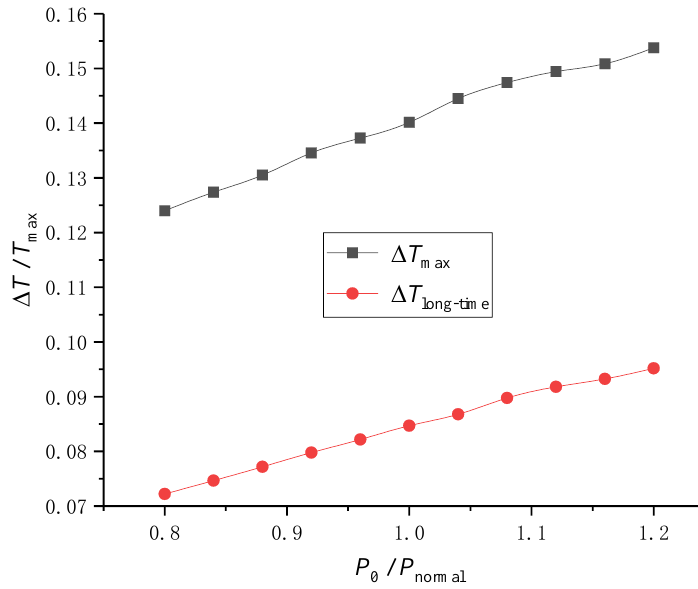
Figure 10. The temperature difference in different initial pressures. The temperature difference ∆ T in different water leakage flows are shown in Figure 11. The water leakage flow had little effect on the temperature difference. This is because the water leakage flow was far less than the feedwater flow in normal operation and there were multiple J-type tubes distributed on the feedwater ring of the steam generator. Under different low water leakage flows, the feedwater entered the descending channel through different numbers of J-type tubes, so their velocities were almost equal, and the values of Ri were almost the same. Therefore, the water leakage flow had little effect on the thermal stratification phenomenon.